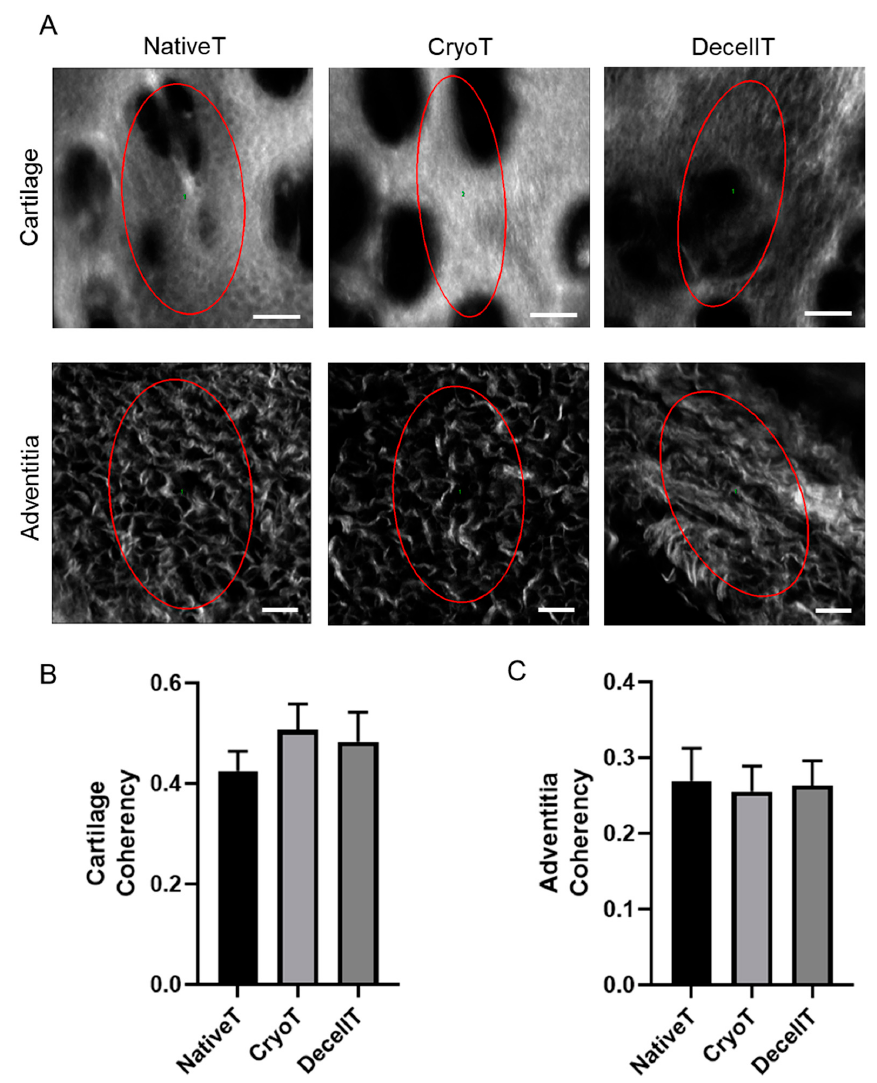
Figure 10. Evaluation of collagen fibers distribution into the cartilaginous compartment and adventitia side of cryopreserved and decellularized tracheas (CryoT and DecellT, respectively) versus native trachea (NativeT) used as reference. ( A ) Second Harmonic Generation (SHG) signal is showed in gray; in accordance with the Fast Fourier Transforms (FFTs), the ellipsoidal fibre orientation, suggesting anisotropy, is described by the red ellipse profile inside each photomicrograph. ( B , C ) Average values of collagen Coherency, which estimates the local orientation of the fibres in the cartilage (0.42 ± 0.04; 0.51 ± 0.05; 0.48 ± 0.06 for NativeT, CryoT and DecellT respectively) and adventitia (0.27 ± 0.04; 0.25 ± 0.03; 0.26 ± 0.03 for NativeT, CryoT and DecellT respectively); coherency was calculated using the ImageJ plugin OrientationJ. No significant difference was identified among groups. Scale bar: 20 µm.